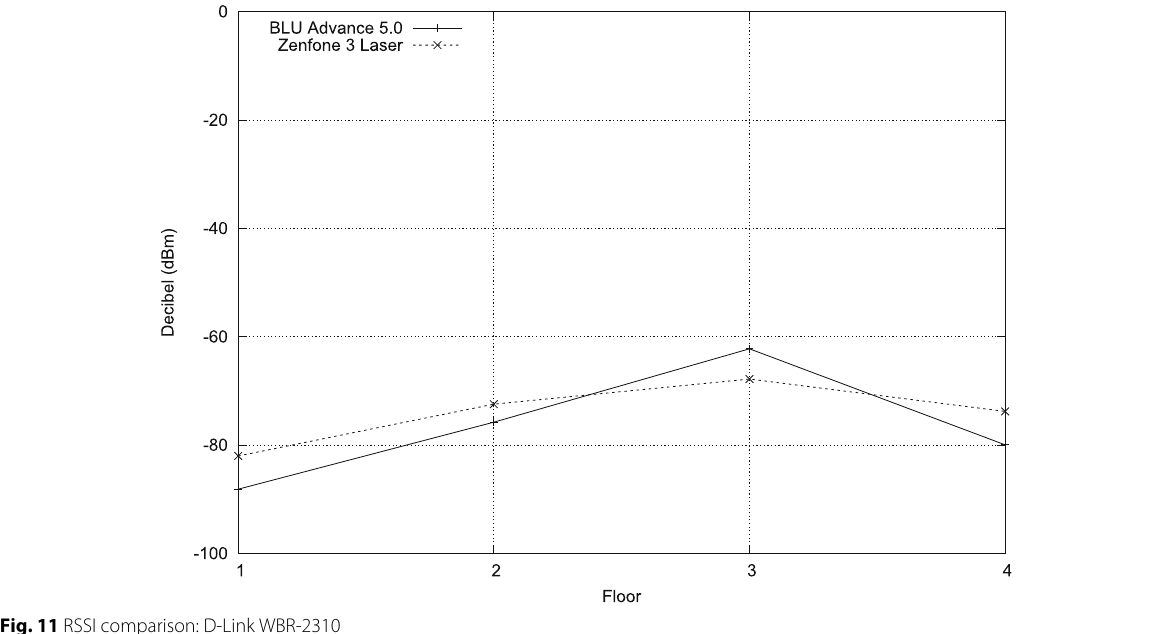
Fig. 11 RSSI comparison: D-Link WBR-2310